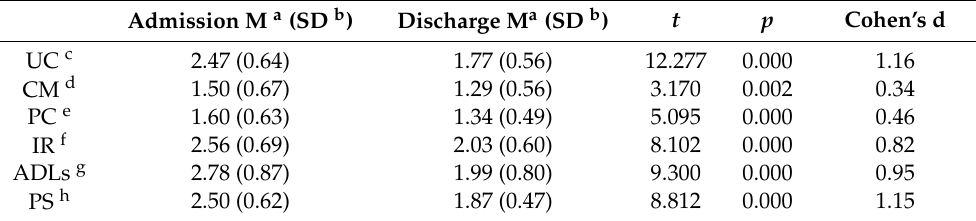
Table 2. Simple effects of time on the different WHODAS factors according to the professional’s